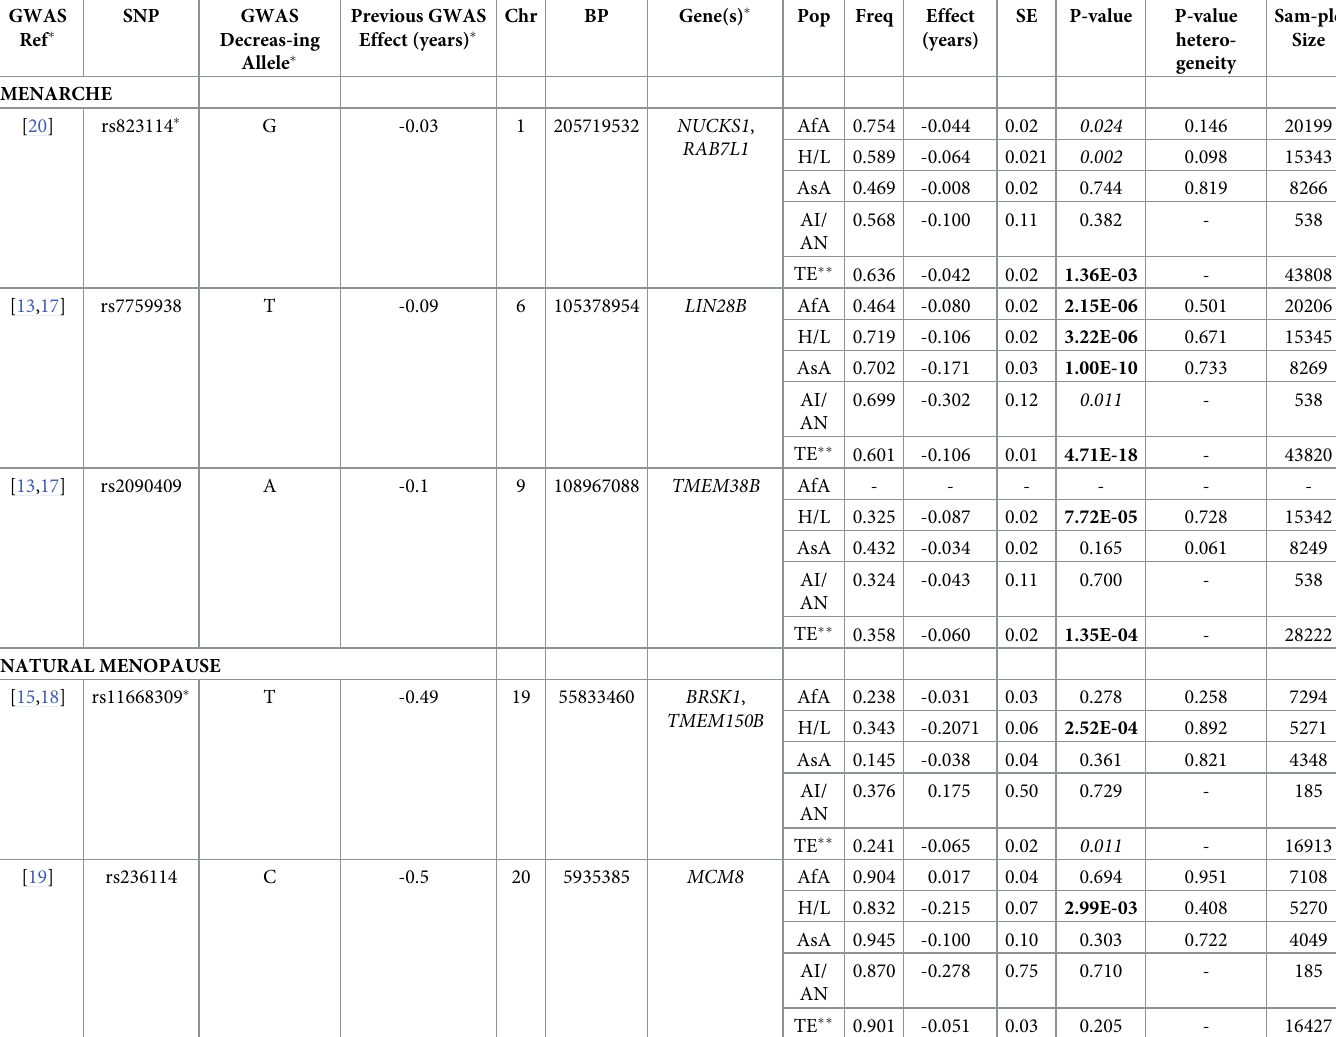
Table 2. Generalization of five previously described age at menarche and natural menopause loci to multiple race/ethnic groups or trans-ethnically. GWAS Ref (cid:3) MENARCHE